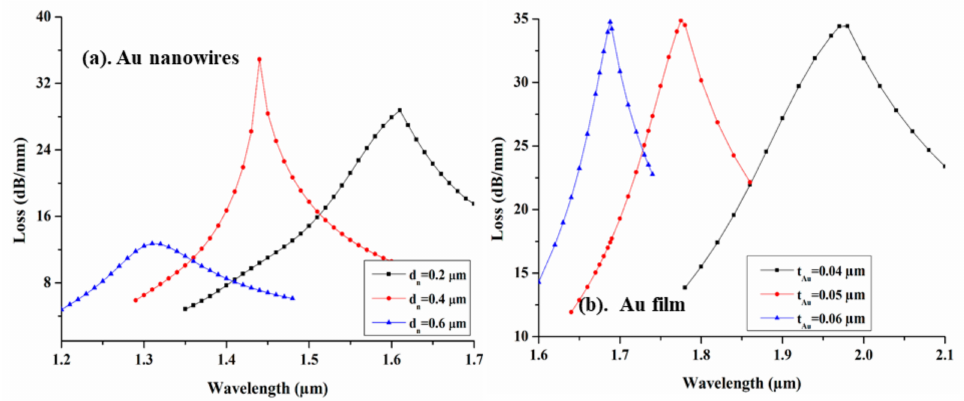
Figure 5. Variation in loss spectra with the wavelength for at di ff erent d n and t Au ( a ) AuNWs and ( b ) Au film,